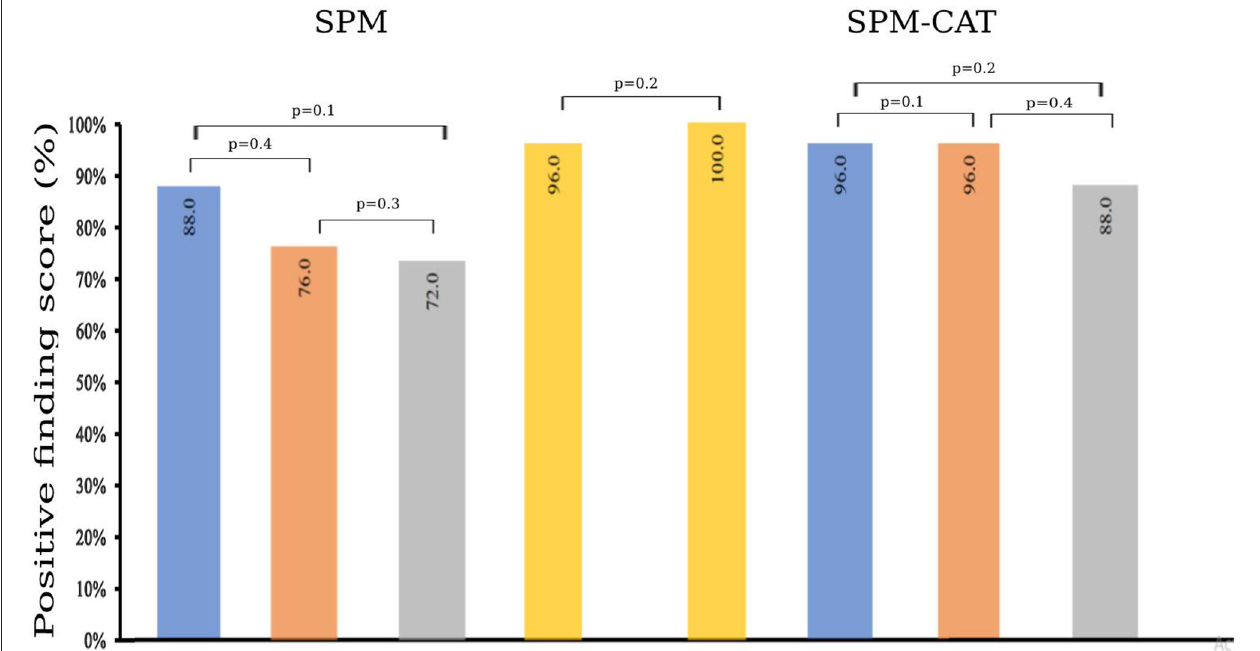
FIGURE 5 | Correct localization percentage of SPM and SPM-CAT with different parameter settings ( p -value is from McNemar’s test and ∗ means p < 0.05).